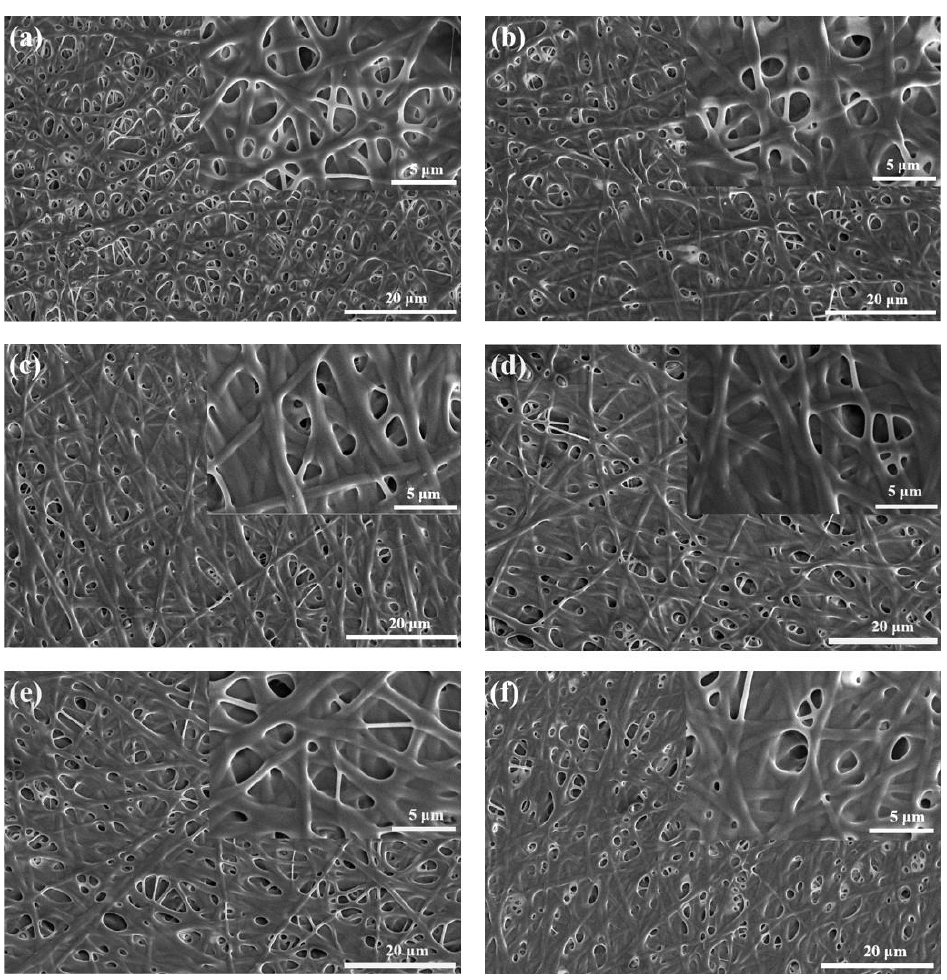
Figure 1. Scanning electron micrograph (SEM) of crosslinked gelatin/genipin fiber membranes with different levofloxacin (Lev) content: ( a ) 0 wt%, ( b ) 1 wt%, ( c ) 2 wt%, ( d ) 3 wt%, ( e ) 4 wt%, ( f ) 5 wt%.